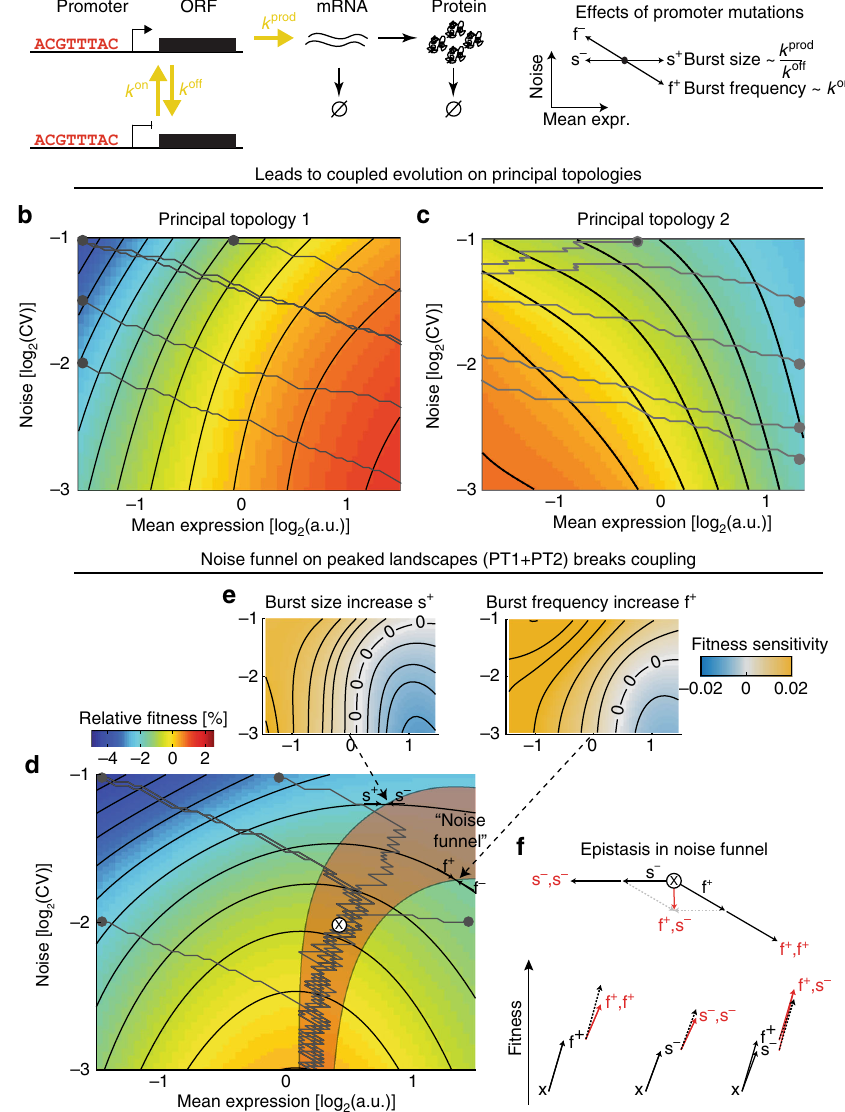
Fig. 6 Peaked expression- fi tness landscapes can break the coupled evolution of mean and noise. a Expression of proteins in a two-state telegraph model of transcriptional dynamics. The promoter switches between transcriptionally permissive and prohibitive states, with rates k on and k off . In the permissive state, mRNAs are transcribed at rate k prod , resulting in transcriptional bursts. mRNAs are then translated to proteins; and both are degraded eventually. Promoter mutations affect transcriptional bursts by changing their size (altering k prod or k off ) or their frequency (altering k on ). Mutations that affect burst size result in concordant changes in mean expression, without affecting noise. Mutations that affect burst frequency result in concordant changes in mean expression and opposing changes in noise. b – d Evolution of gene expression properties via promoter mutations on principal topology 1 (sensitivity to protein shortage, panel b ), principal topology 2 (sensitivity to protein surplus, panel c ) or peaked (sensitivity to protein shortage and surplus, panel d ) fi tness landscapes. Each grey trajectory is one realization of a stochastic walk, where the likelihood of steps depends on their fi tness gains (circles indicate starting genotype). All grid points on the landscape are assumed to be accessible genotypes. In panel d , red patch indicates noise funnel, where burst size- decreasing mutations (s − ) and burst frequency-increasing mutations (f + ) are bene fi cial, which results in alternating steps towards lower noise levels. x in noise funnel marks point used to exemplify epistasis in panel f . e Fitness gains of mutations increasing burst size (s + , left) or increasing burst frequency (f + , right) on peaked landscape. Borders of no gain (contour marked by 0 ’ s) do not align due to additional fi tness gains from reduced noise in mutations increasing burst frequency, creating the noise funnel on the peaked fi tness landscape. f Upper: Resulting mean/noise effects of different combinations of increased burst frequency (f + ) and decreased burst size (s − ) mutations. Lower: Fitness and epistasis from mutation combinations. First step: fi tness of individual mutations. Second step: Expected fi tness (black, dashed) and observed fi tness (red, solid) of combined mutations. Epistasis is the difference between observed and expected fi tness. Starting genotype x is marked on peaked fi tness landscape in panel